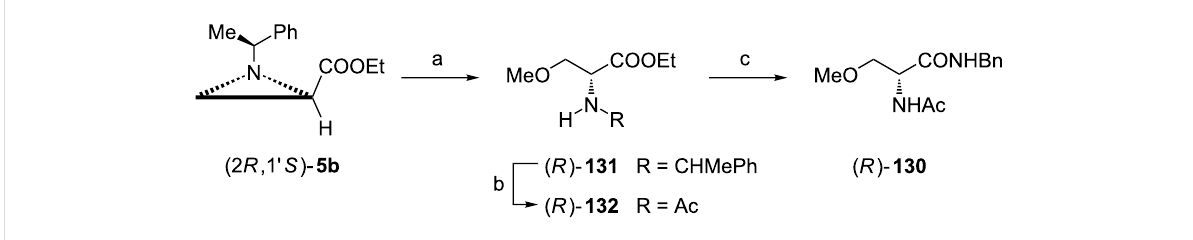
Scheme 34: Synthesis of lacosamide, ( R )-2-acetamido- N -benzyl-3-methoxypropanamide ( R )- 130 . Reagents and conditions: a) MeOH, BF 3 ·OEt 2 , MeCN, 90 °C, 3 h; b) H 2 , 20% Pd(OH) 2 /C, Ac 2 O, EtOH, rt, 14 h; c) BnNH 2 , Me 3 Al, CH 2 Cl 2 , rt, 3 h.